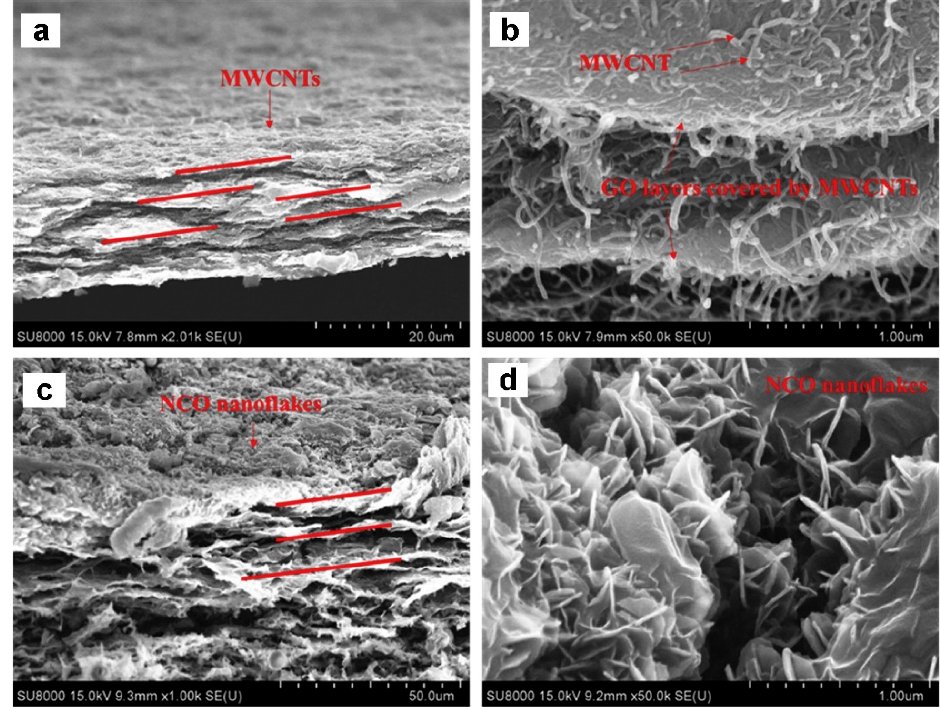
Figure 5. SEM images of ( a , b ) GO/CNTs and ( c , d ) NiCo 2 O 4 @GO/CNTs at different magnifications. Reproduced with permission from [81]. Copyright 2019, Elsevier.